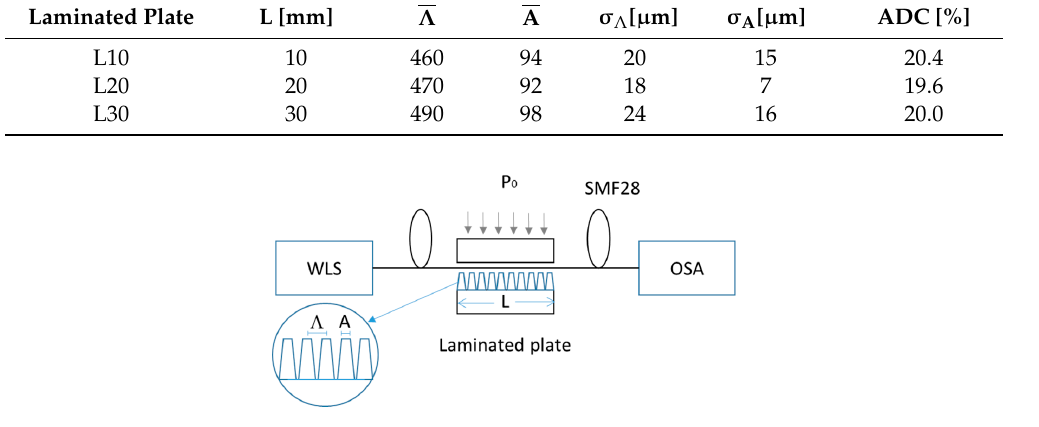
Figure 4. Experimental configuration.